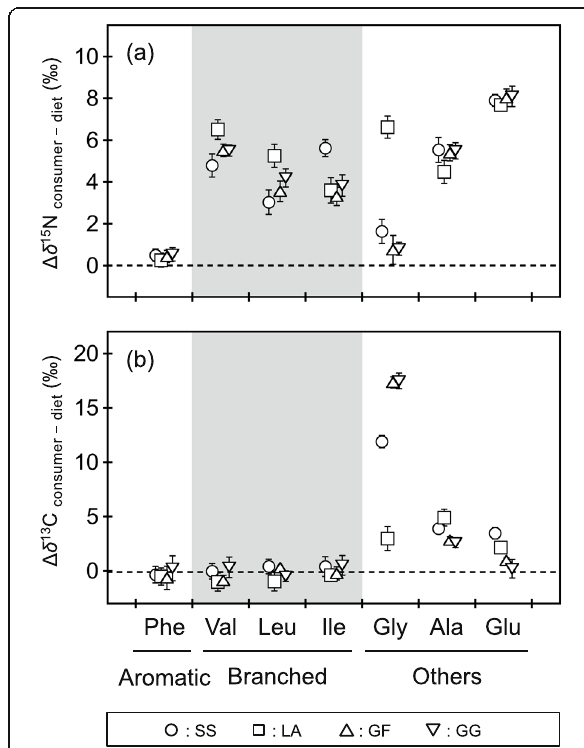
Fig. 2 a Δ δ 15 N and b Δ δ 13 C values of amino acids in the consumer – diet combinations for sea slug feeds on sponge (SS), ladybug beetle feeds on aphid (LA), green lacewing feeds on fall armyworm (GF), and green lacewing feeds on green lacewing (GG). Error bar indicates standard deviation (1 σ ) of replicate measurements